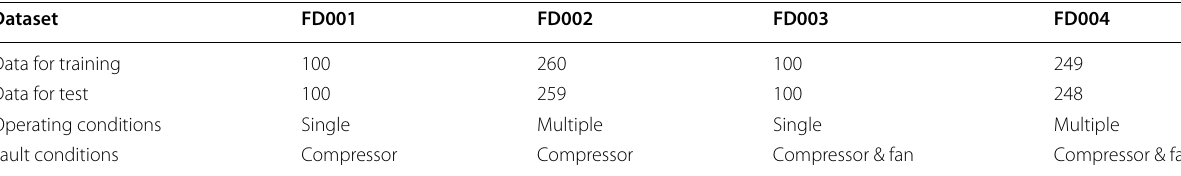
Table 1 C-MAPSS